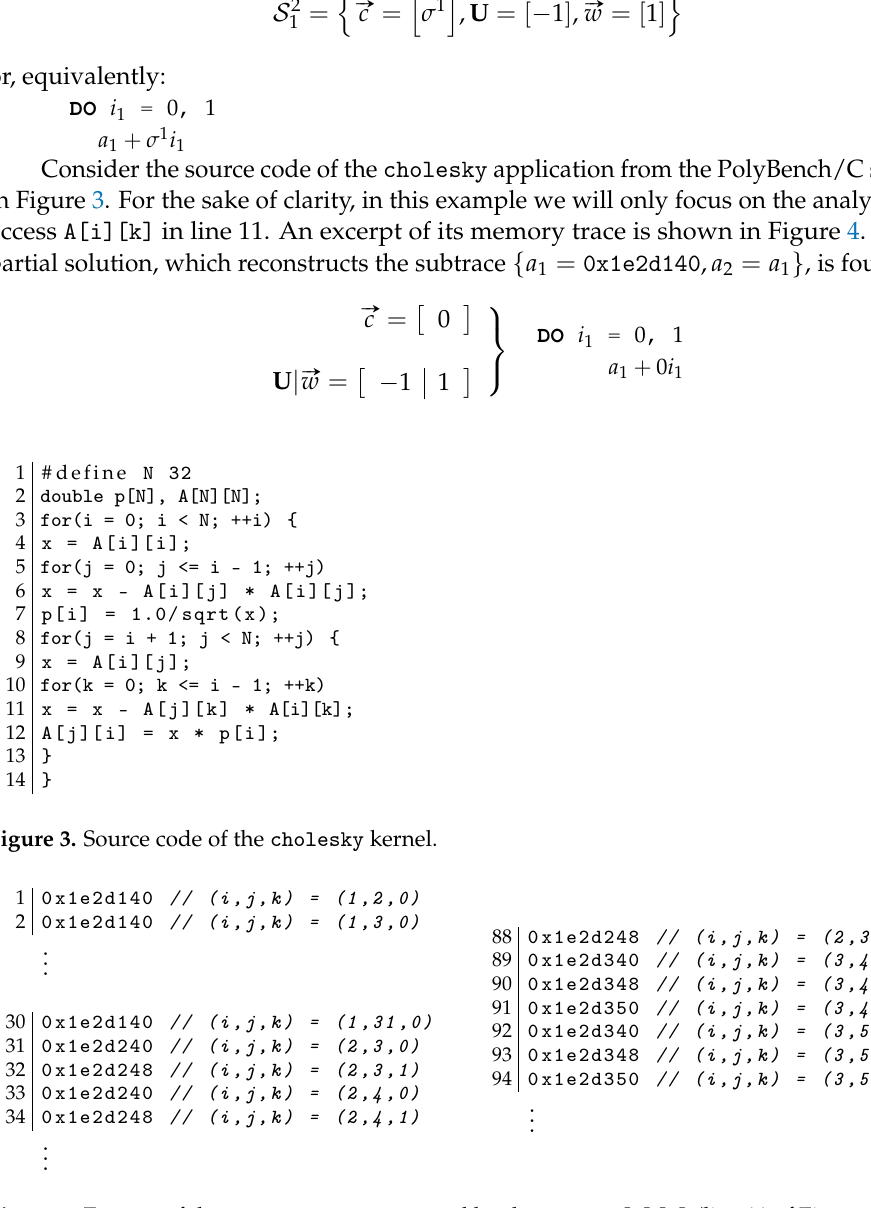
Figure 4. Excerpt of the memory trace generated by the access A[i][k] (line 11 of Figure